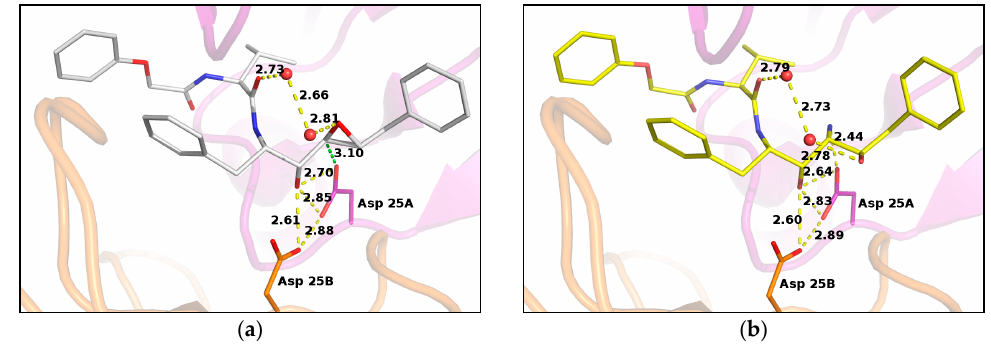
Figure 3. PR/EPX structures showing interactions with catalytic aspartates in PR/EPX before and after triggered reaction. ( a ) pH 6.0, PR/EPX structure showing interactions with catalytic aspartates. The carboxylate oxygen atom of the catalytic aspartate, in close contact to the oxirane carbon (green dashed line), forms an angle of 95° with the carbon–carbon bond of the ring; ( b ) pH 9.0, reacted pseudopeptide epoxide inhibitor produces a serinol derivative. The amino group forms a strong H-bond with a carboxylate oxygen atom of a catalytic aspartate. Interatomic distances are depicted as yellow dashed lines, except otherwise stated, with distance value in Angstrom.